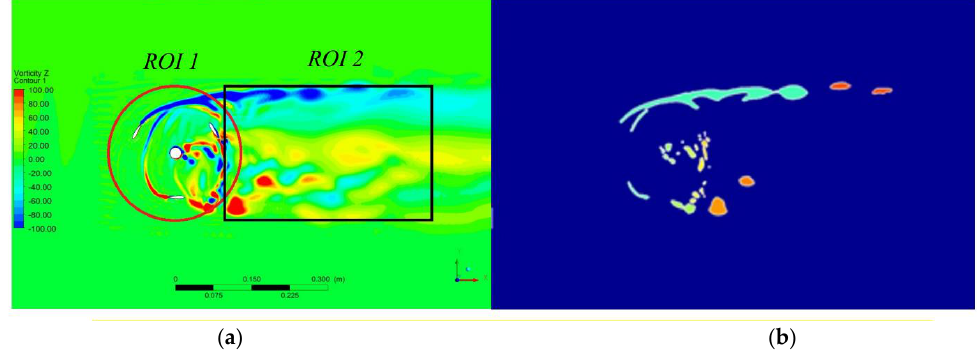
Figure 6. ( a ) ROI in the instantaneous vorticity field on the symmetry plane for the URANS model, ( b ) Vortex capture by image processing in regions of interest in a vorticity contour.